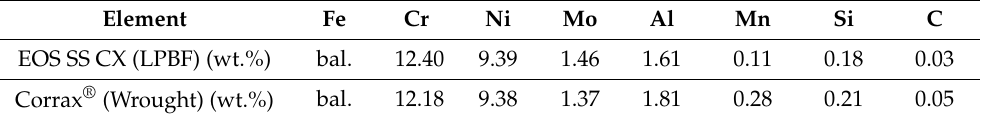
Table 1. Measured chemical compositions of the EOS Stainless Steel CX and Uddeholm Corrax ® in the initial state. Element Fe Cr Element EOS SS CX (LPBF) (wt.%) Corrax ® (Wrought) (wt.%)